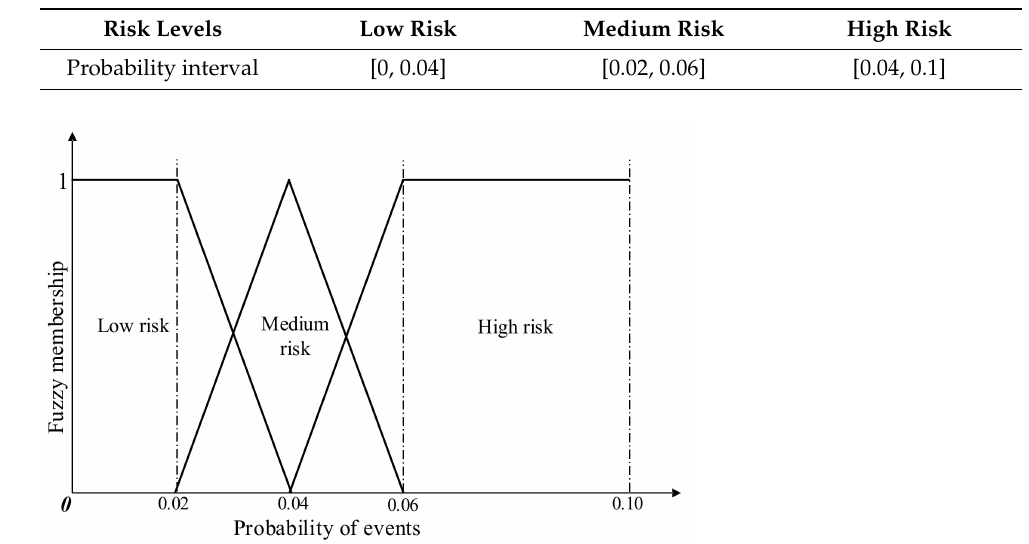
Table 4. Probability interval of the risk levels.